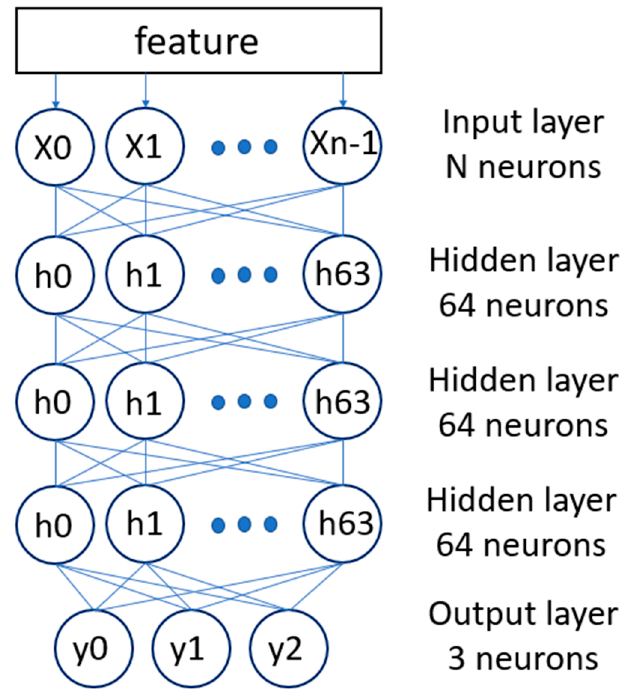
Figure 5. DNN Architecture of Life cycle Model.